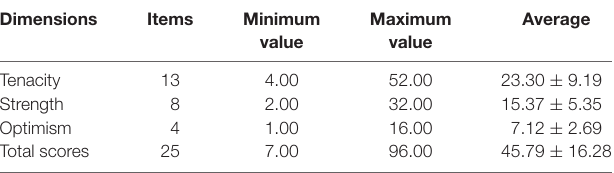
TABLE 2 | Total scores and score of each dimension of psychological resilience in patients with complicated hepatolithiasis ( n = 156).